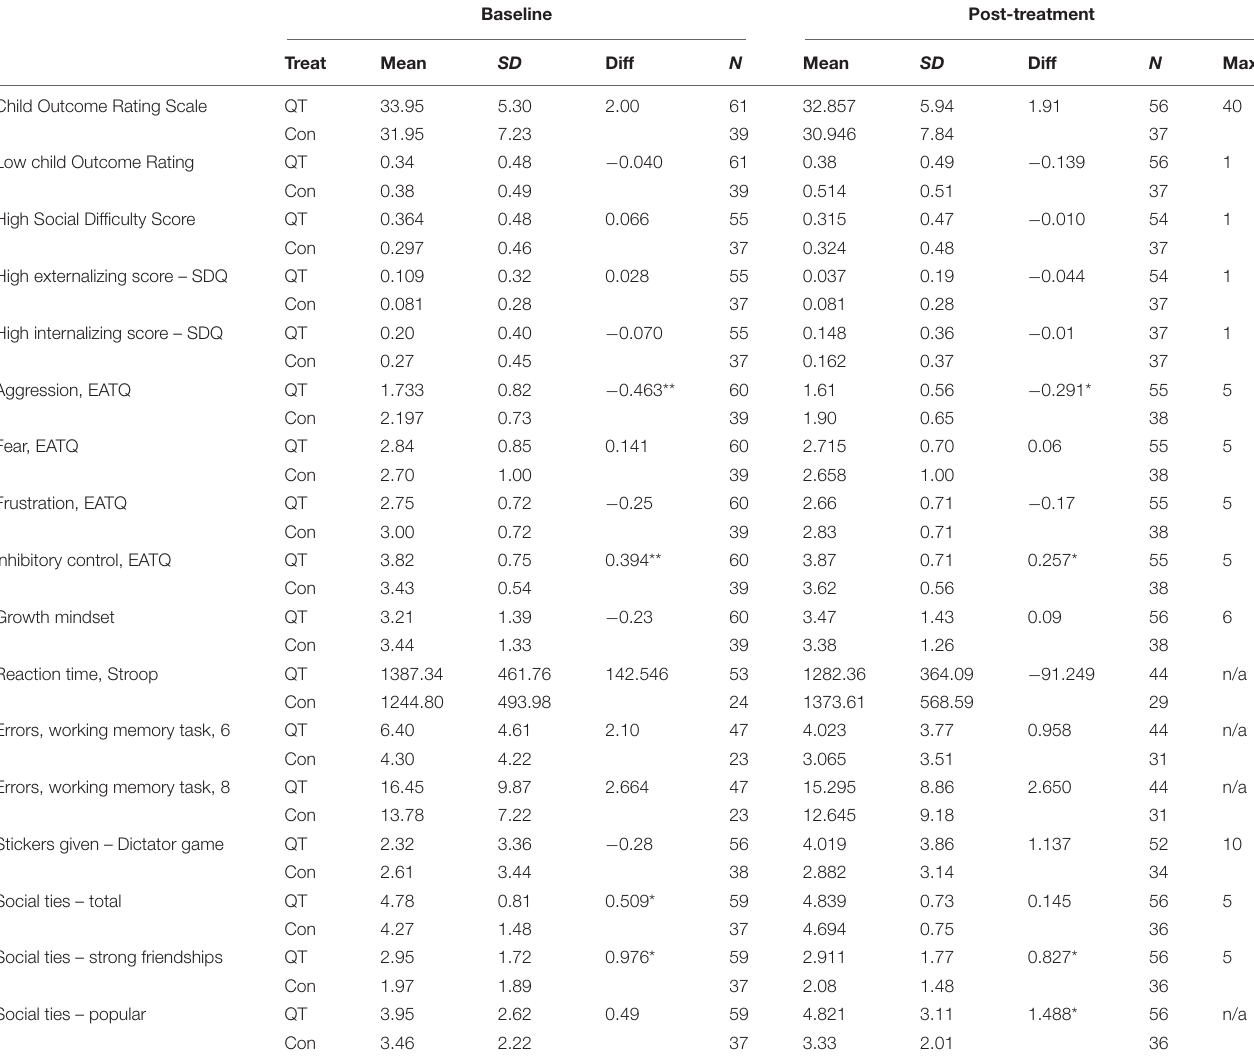
TABLE 5 | Descriptive statistics of the outcome variables before and after the intervention in the Irish setting. Baseline